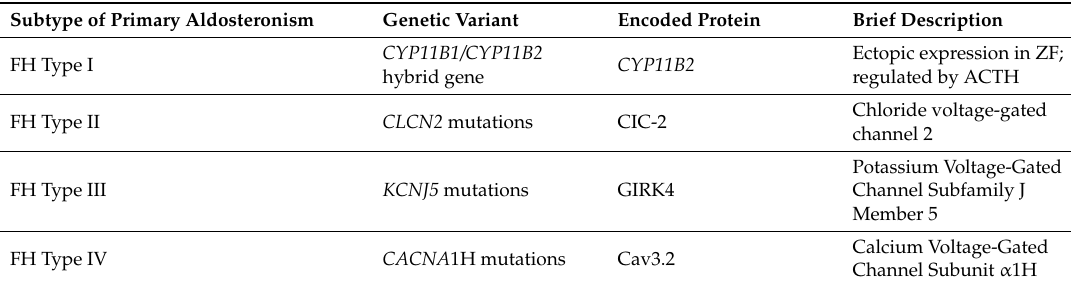
Table 1. Familial forms of